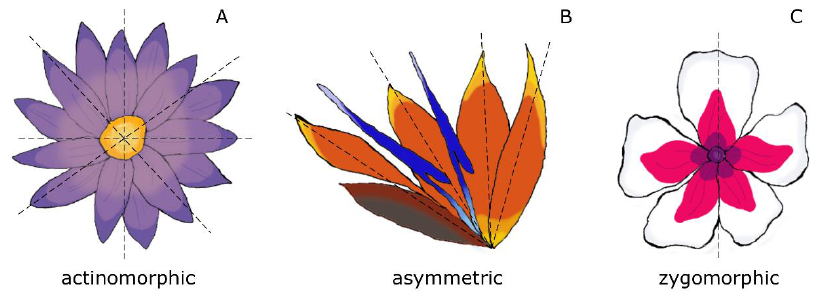
Di ff erent types of floral symmetry; ( A ) radially symmetric flower (actinomorphic), ( B ) asymmetrical flower, ( C ) bilaterally symmetric flower (zygomorphic).